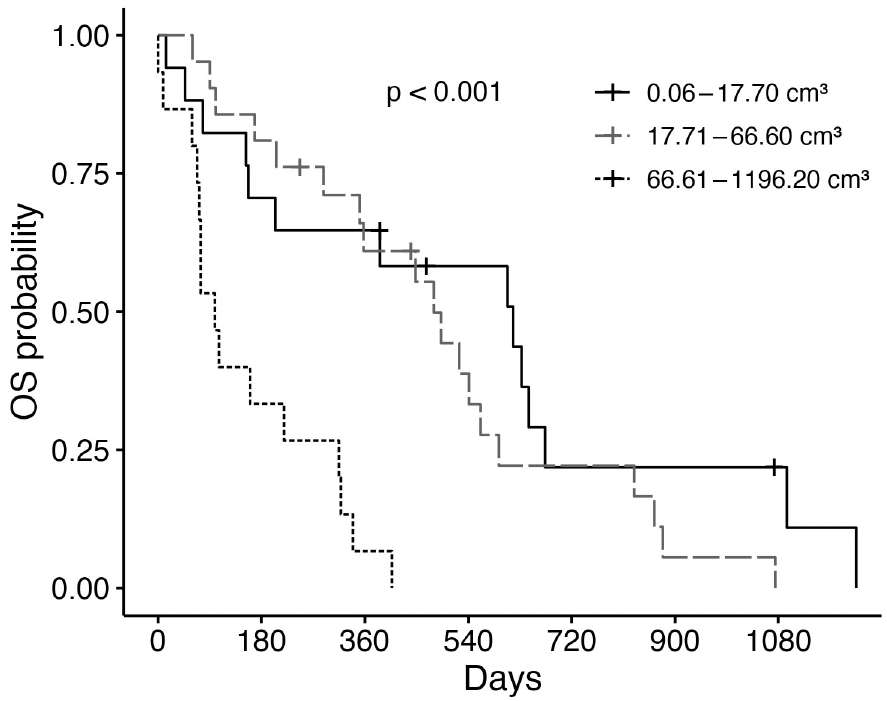
Fig 7. Overall median survival time for dogs with adenocarcinoma stratified by volume. Overall survival (OS) curves for dogs with lung adenocarcinoma were stratified by tumor volume. Ticks represent dogs censored from analysis. Dogs were censored if they were alive at the time of last follow-up. The median overall survival time (OST) for dogs with smaller (0.06–17.70 cm 3 ) lung adenocarcinomas was 618 days (95% confidence interval [CI]: 204 days-not found) compared to 480 days for dogs with intermediate (17.71–66.60 cm 3 ; CI: 351–829 days) tumors and 99 days for dogs with large (66.61–1196.20 cm 3 ; CI: 72–318 days) tumors.